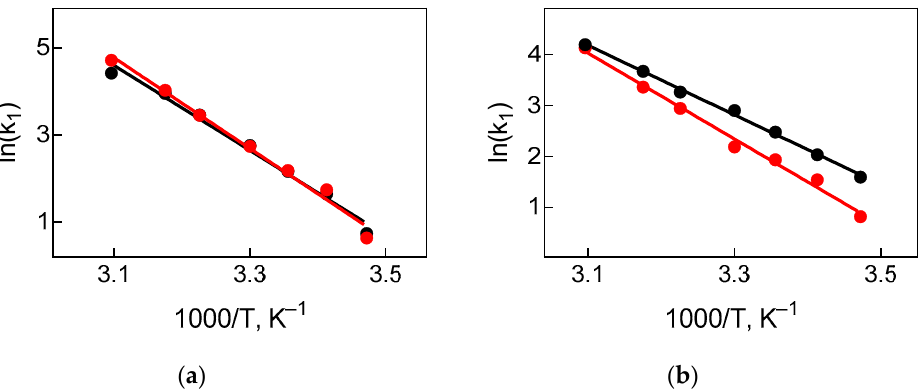
Figure 5. Temperature dependence of rate constants of tRNA translocation (Arrhenius plot). Tem- perature dependence of translocation rate constants, k 1 , upon addition of EF-G (5 µM) from E. coli (black circles) or T. thermophilus (red circles) detected by the label ( a ) at the elbow region of tRNA or ( b ) at CCA-end of tRNA. Rate constants are from Table 1. Mean and s.e.m. are plotted; the latter, however, do not exceed the size of symbols. The activation energy of the reaction is defined to be ( − R) times the slope of the Arrhenius linear plot, where R is a gas constant with an approximate value of 8.31446 J ∙ K − 1 ∙ mol − 1 .